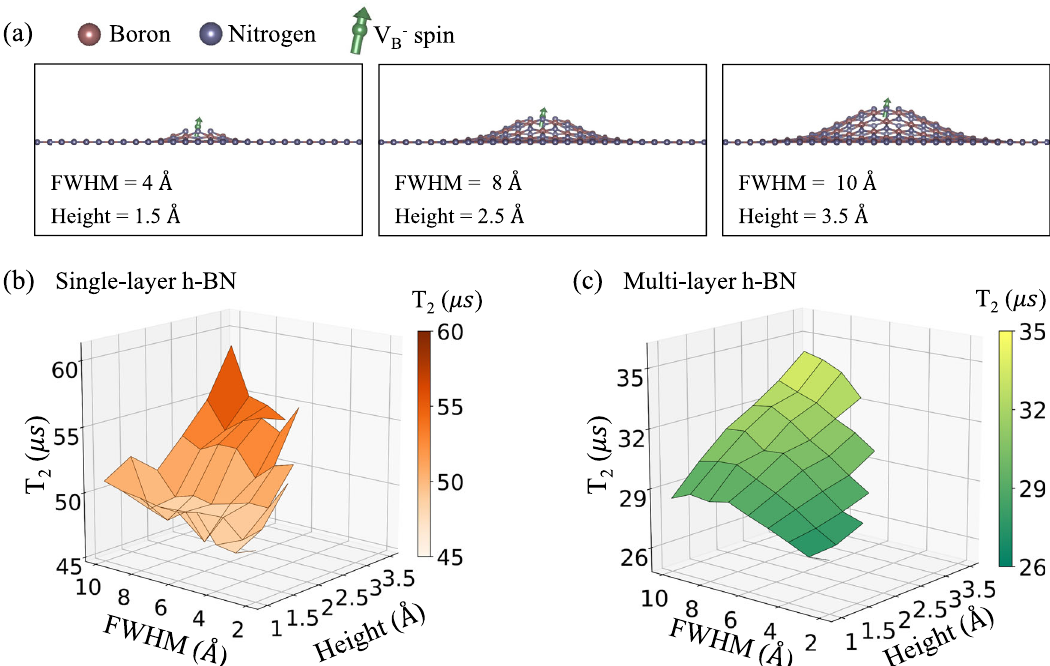
Fig. 4 Strain-induced increase in the T 2 time of V B − . a Gaussian-shaped lattice deformation of h-BN to induce an inhomogeneous strain around the V B − . To control the degree of the lattice deformation, the height (Z) and FWHM of the Gaussian function are varied. b , c Computed T 2 times of the V B − spin in ( b ) single-layer and ( c ) multi-layer h-BN as functions of the FWHM and height of the Gaussian lattice-deformation function. An external magnetic fi eld of 3 T is